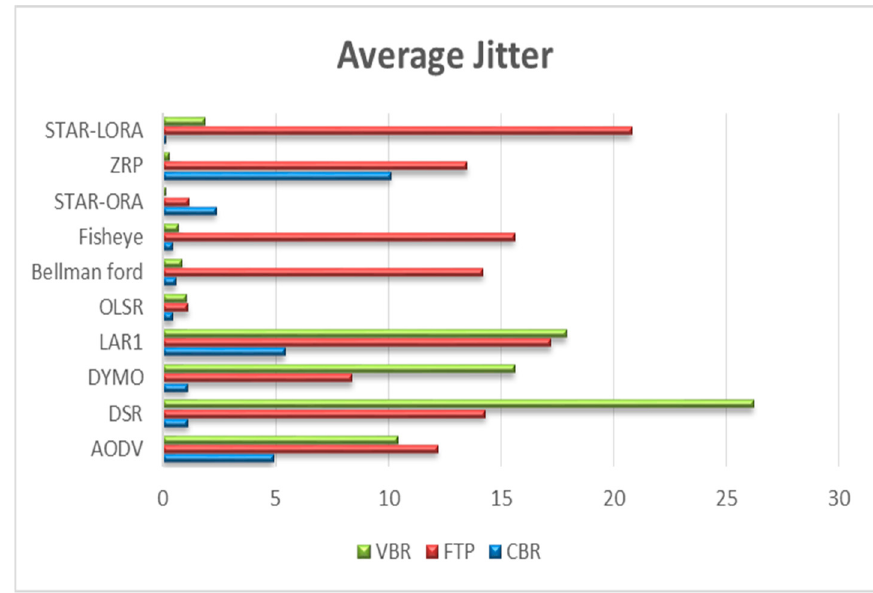
Figure 20. Average jitter of all routing protocols for 60 nodes.